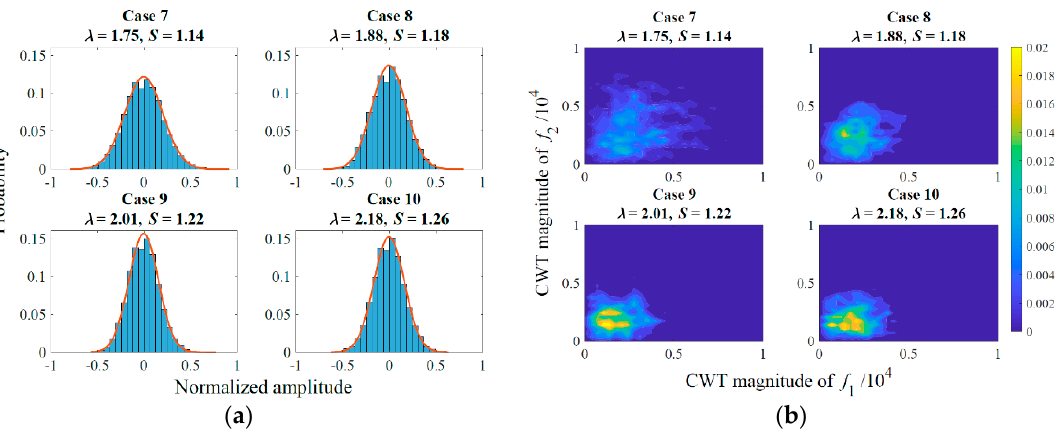
Figure 8. Combustion in V-shaped mode until blowout at p g = 0.3 bar and Q15-D: Cases 7–10. ( a ) Histograms of the pressure signal and ( b ) joint histograms of the CWT coefficients at f 1 and f 2 (bottom).